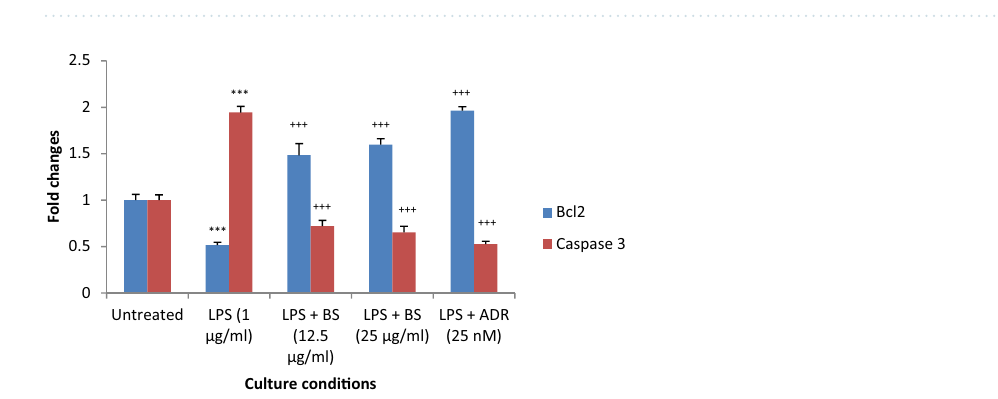
Figure 8. Cytoprotective effect on LPS induced cytotoxicity in human Leydig cells (in-vitro). All values are mean ± SEM, n = 6.